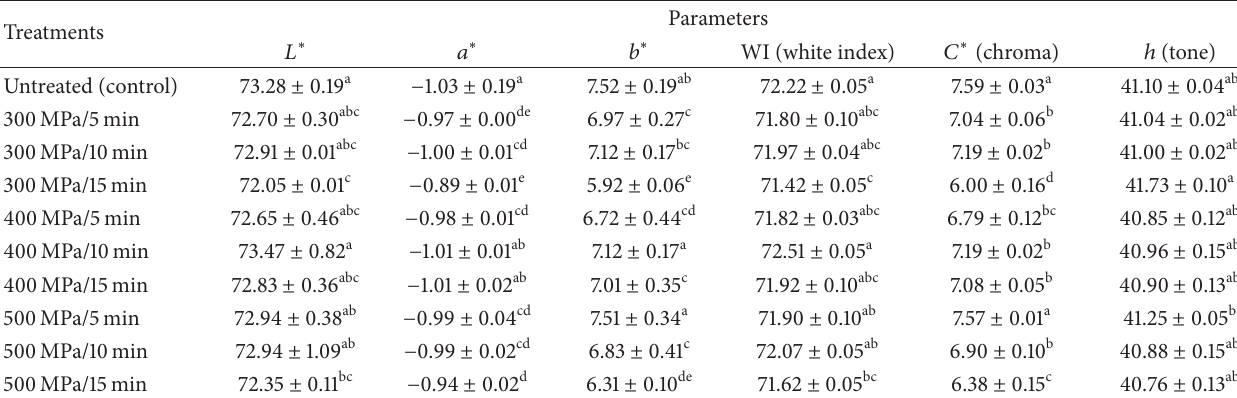
Table 4: Effects of HHP oncolour parameters of white wine.